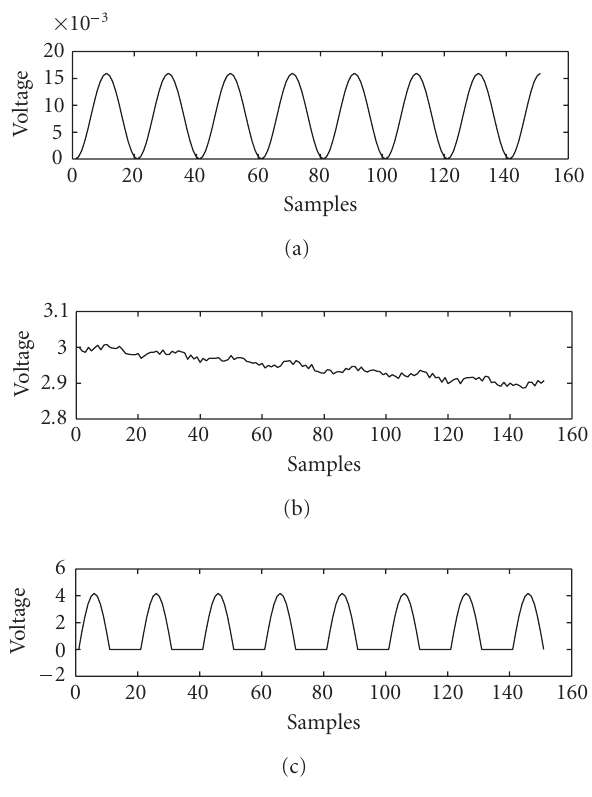
Figure 3.1. Perturbation result for half-wave rectifier: top most figure shows the zeroth-order pertur- bation followed by the first-order and the second-order,